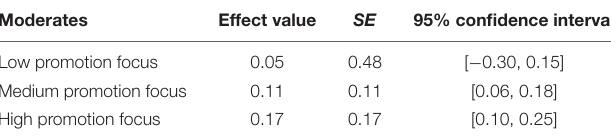
TABLE 3 | Conditional indirect effect